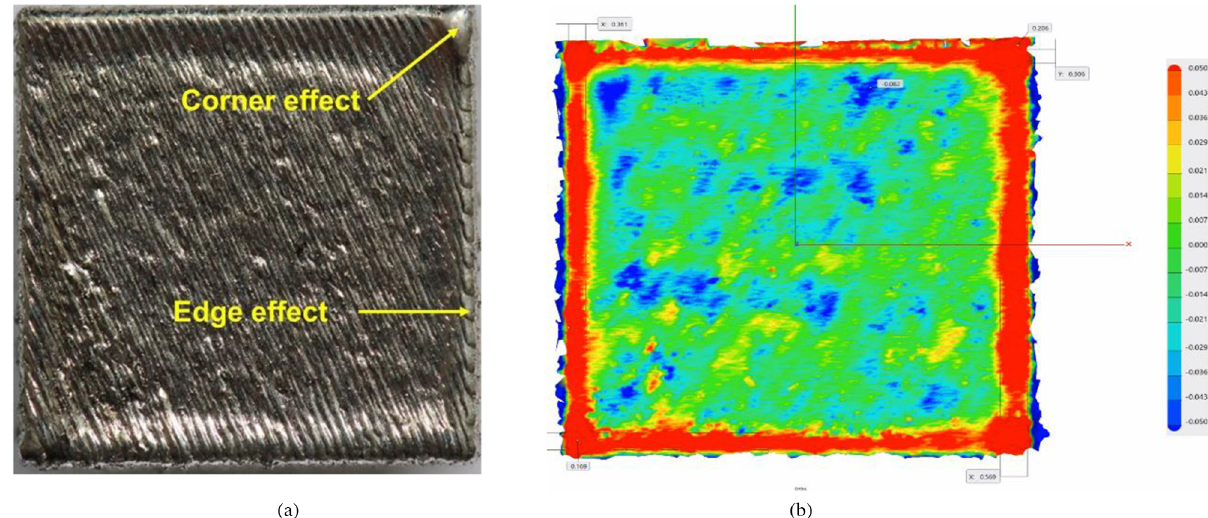
Fig. 2. Macroscopic view of the top surface and the associated scanned surface topography of the specimen built with 250W laser power and 0.7 m · s (cid:3) 1 scanning speed. The real side of the specimen (cid:3) 10